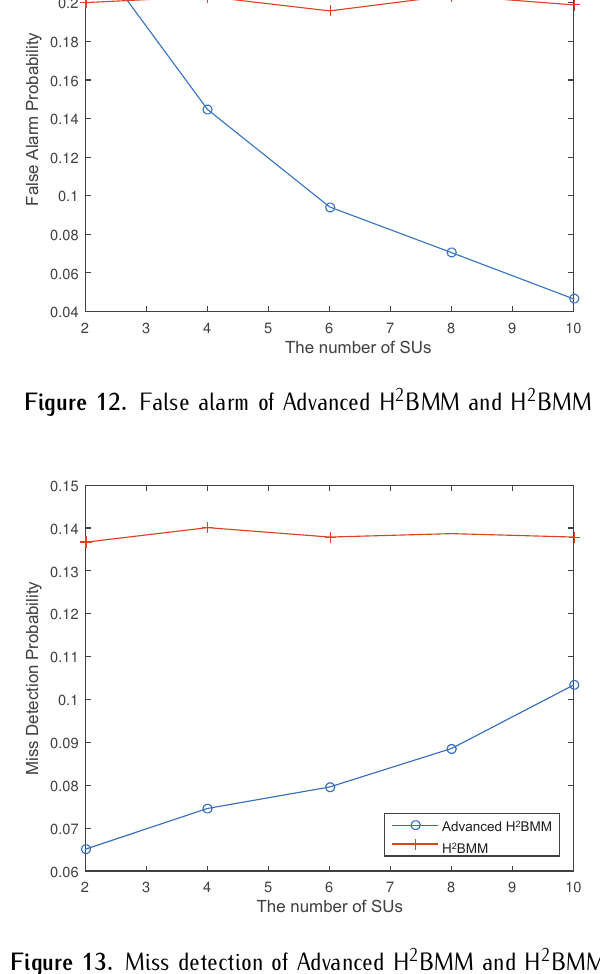
Figure 13. Miss detection of Advanced H 2 BMM and H 2 BMM false alarm probability. The reason why the increase of SU number has no significant e ff ect on H 2 BMM has been explained in Fig.